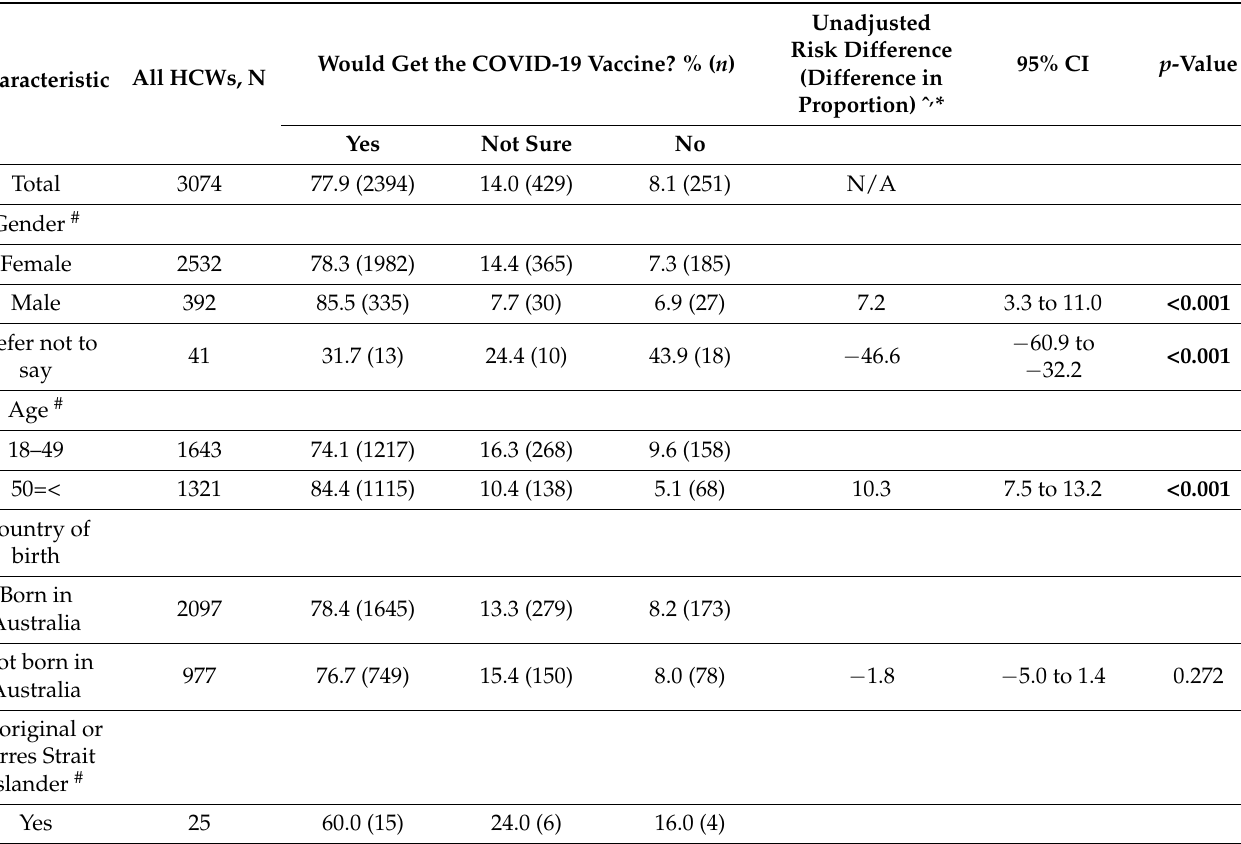
Table 2. Demographic characteristics associated with COVID-19 vaccine acceptance, by total